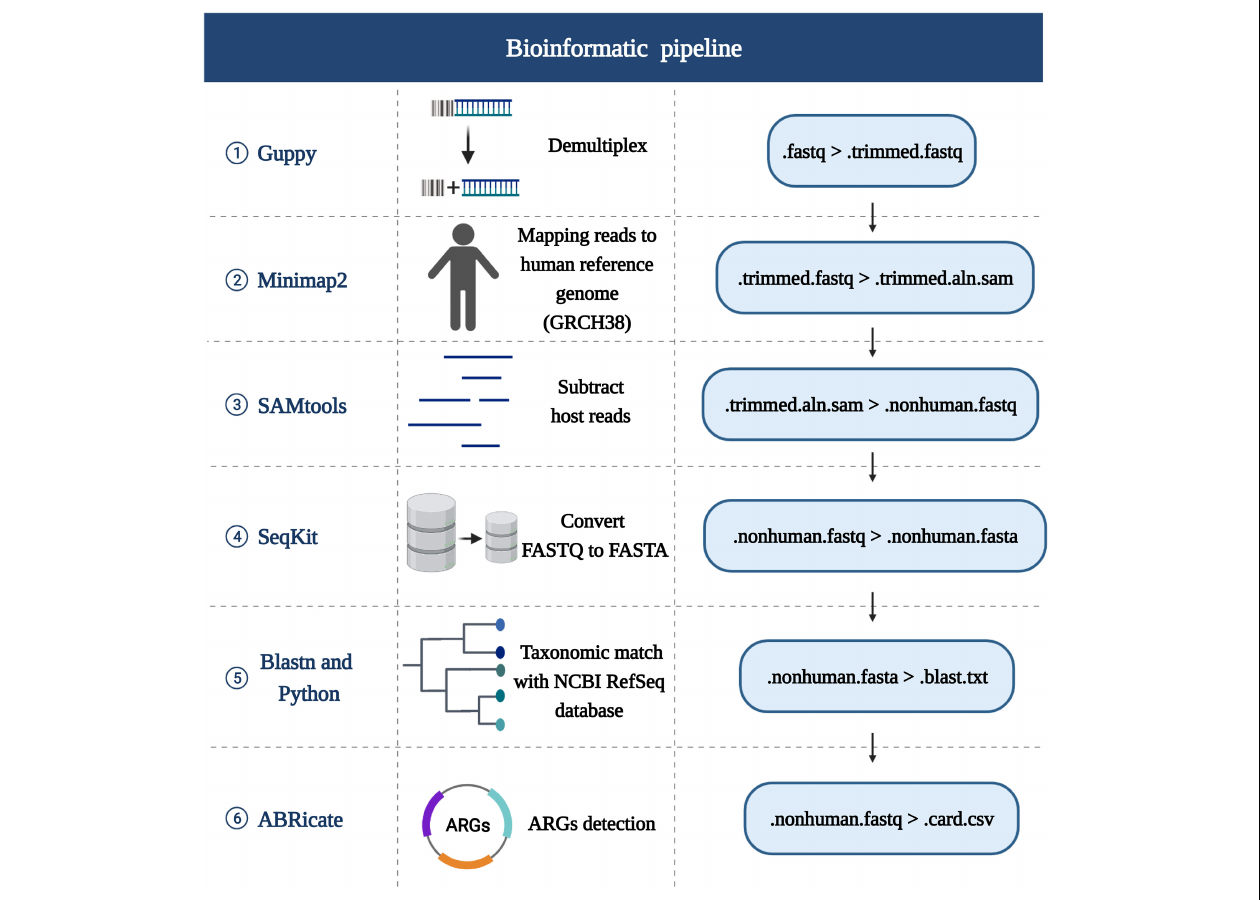
FIGURE 2 | Schematic of the bioinformatics analysis pipeline. The first row lists the tools used for each stage, the second row lists the certain functionality of each step in the pipeline, the third row shows the detailed steps. Created with BioRender.com.